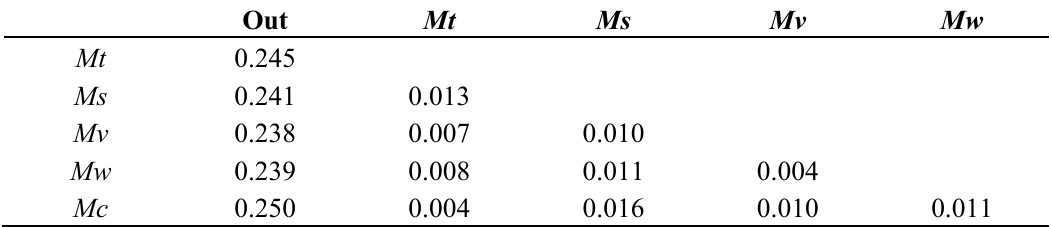
Table 5. Relative to Neodiaptomus schmackeri (out-group), the genetic distance between different populations of Mongolodiaptomus birulai is indicated by the COI gene. The distance was calculated using the Kimura 2-parameter (transition + transversion) method.